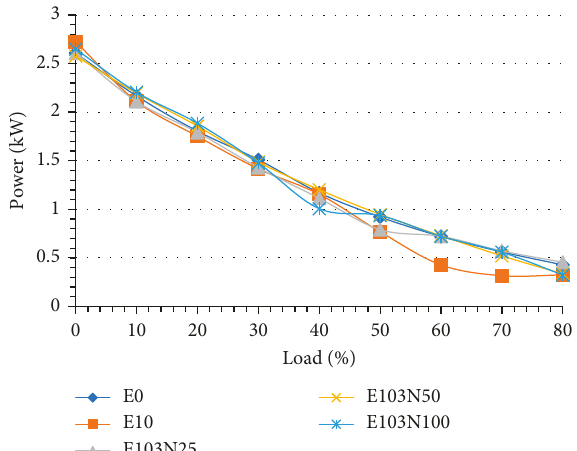
Figure 13: The effect of ethanol on engine fuel